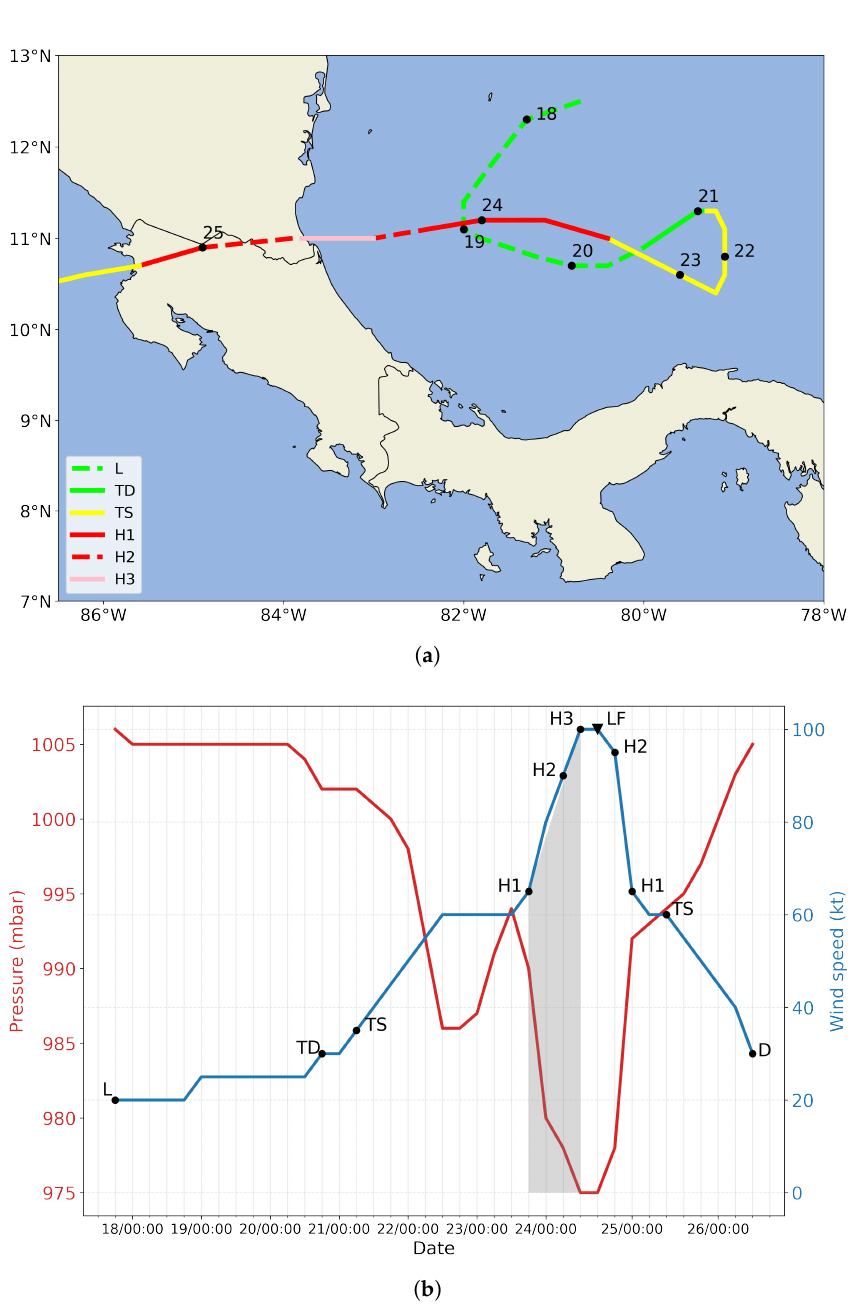
Figure 1. ( a ) Best Track of tropical cyclone Otto from 17 to 25 November 2016. The maximum sustained winds and the central pressure time series are presented in ( b ). The shaded area in ( b ) shows the RI period. The tropical cyclone evolution is indicated by L: low pressure, TD: tropical depression, TS: tropical storm, H1, H2, and H3: hurricane category 1, 2 and 3, LF: landfall and D: dissipation. The data in the x-axis is 6-h spaced, except for the points LF (24/1730 UTC) and TS (25/0330 UTC). Data source from Brown